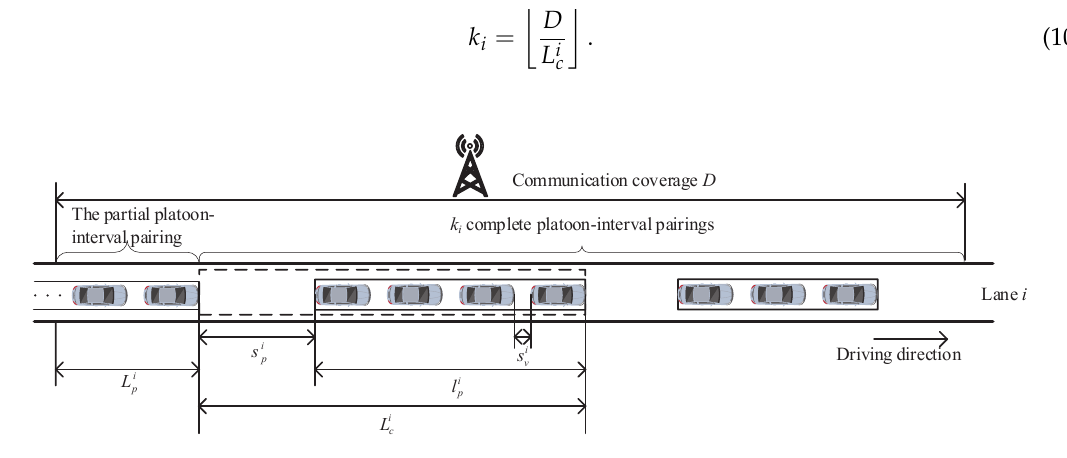
Figure 3. Partial platoon-interval pairing and complete platoon